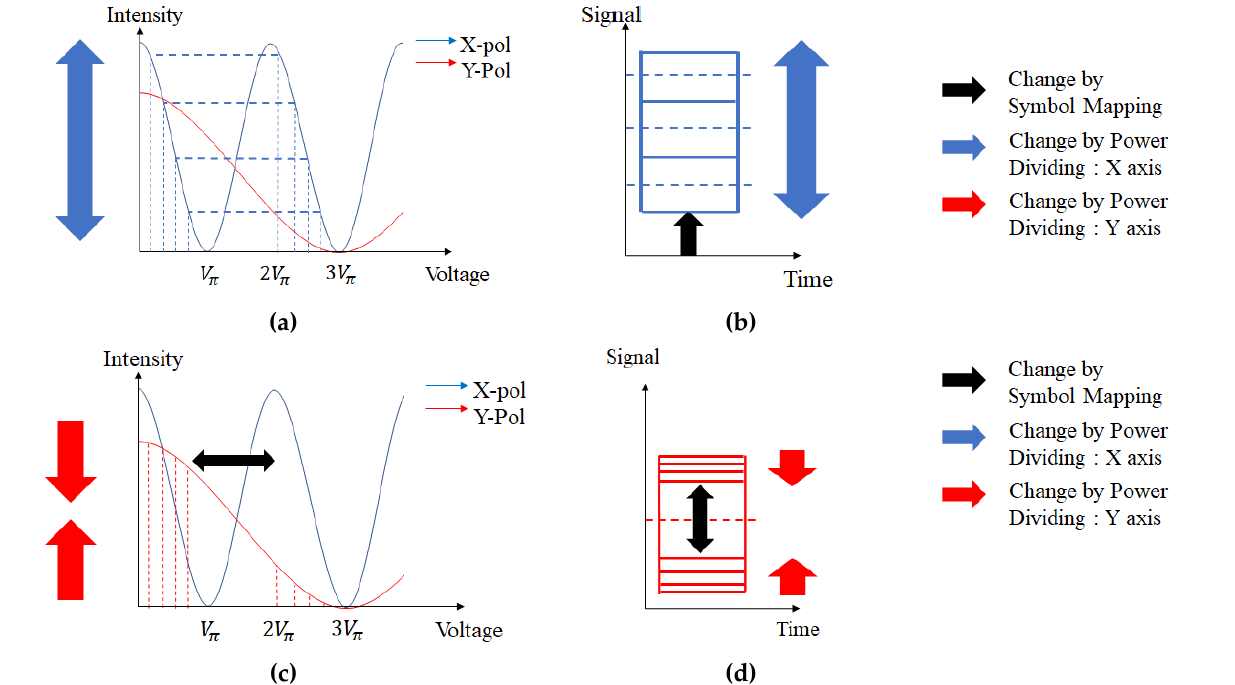
Figure 3. Transfer curves and expected eye diagram for each polarization when the symbol mapping and polarization power rate is changed. ( a ) X -axis voltage vs. intensity transfer curve; ( b ) Expected X -axis eye diagram; ( c ) Y -axis voltage vs. intensity transfer curve; ( d ) Expected Y -axis eye diagram.